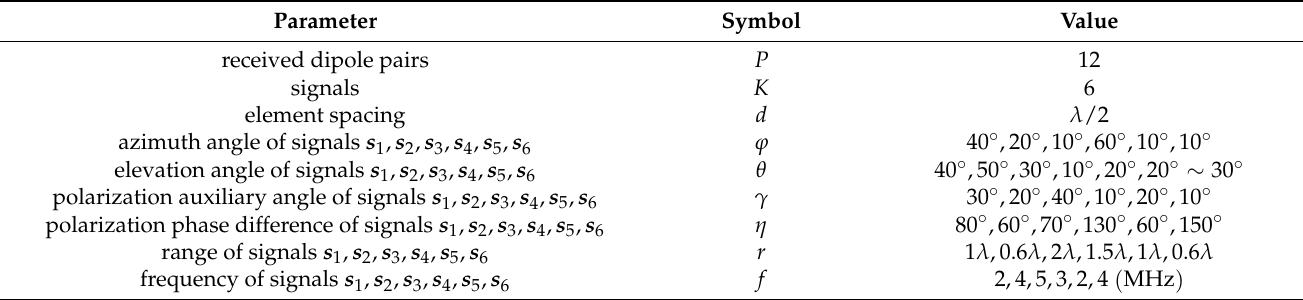
Table 1. Simulation parameters in P-ULA with cross-distribution dipole